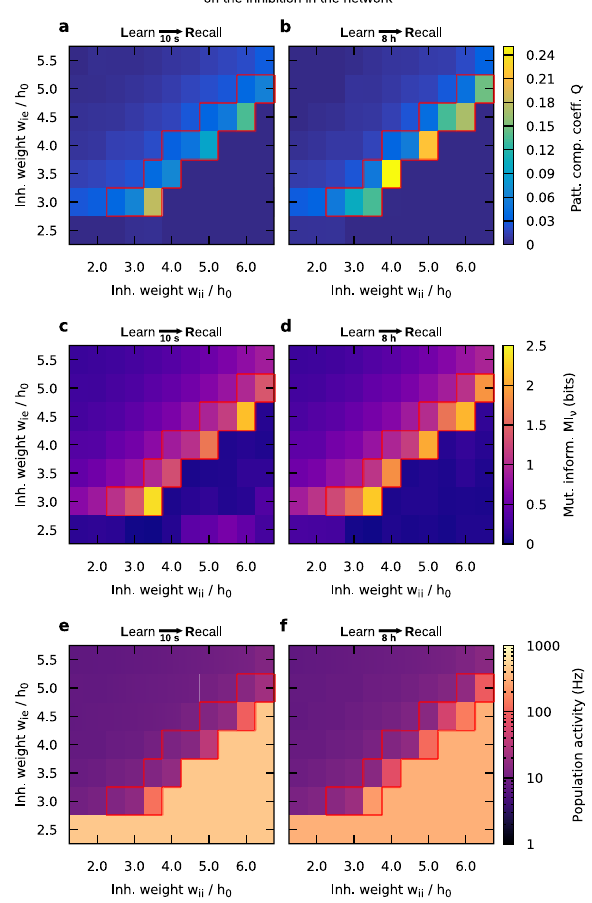
Fig. 4 Quality of the recall 10 s and 8 h after learning as a function of the I → E ( w ie ) and I → I ( w ii ) coupling strengths. Suf fi cient memory functionality is found within a certain regime, marked by a red box ( Q (10s-recall) ≥ 0.03). Two measures of recall quality are shown: a , b the pattern completion coef fi cient Q (with nonsigni fi cant values set to zero, see “ Methods ” section); c , d the mutual information MI ν between the neuronal activities in the network during learning and during recall. e , f For comparison, the neuronal activity averaged over the whole excitatory population is shown. All three observables were averaged over ten trials. Parameters: n CA = 150, I 0 = 0.15